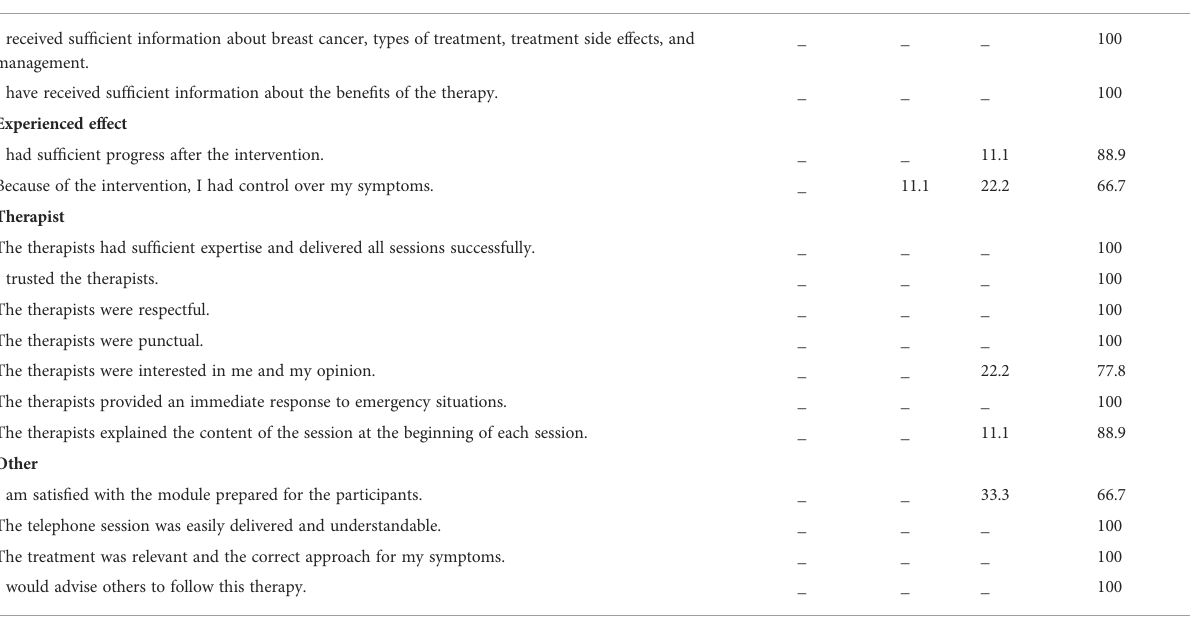
TABLE 3 Participant ’ s evaluation of the intervention among breast cancer